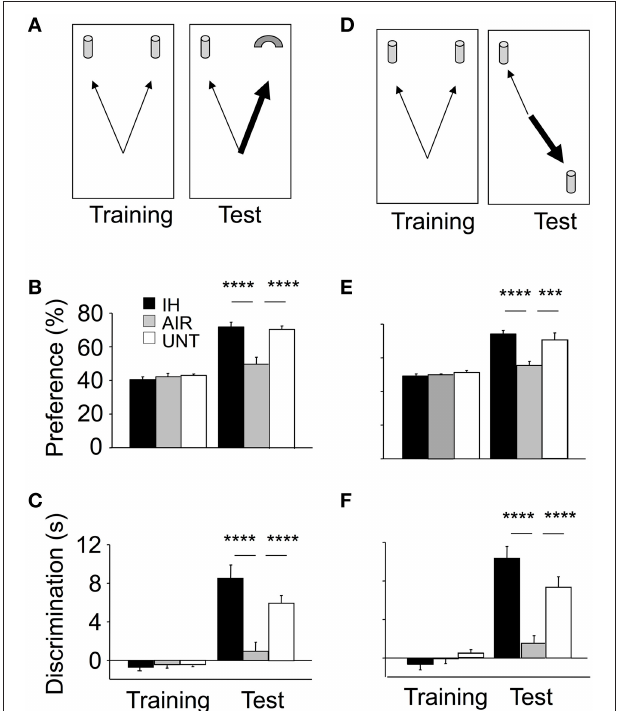
FIGURE 3 | Improvements in memory in mice postnatally exposed to IH. Memory was assessed on P22 using the Object Recognition Task (ORT, A–C ) and Object Location Task (OLT, D–F ). IH, mice exposed to chronic intermittent hypoxia ( n = 20 ); AIR, mice exposed to air ( n = 20 ); UNT, untreated unmanipulated mice left with their dams ( n = 19 ). ORT, (B,C) In the training phase, the three groups tended to equally explore the two objects. In the ORT test phase, the IH group had significantly higher preference (B) and discrimination (C) indices compared to the AIR group; with both values similar to those in the UNT group. OLT, (E,F) gave similar results. Values are group means ± SEM. *** p < 0.001 ; **** p < 0.0001